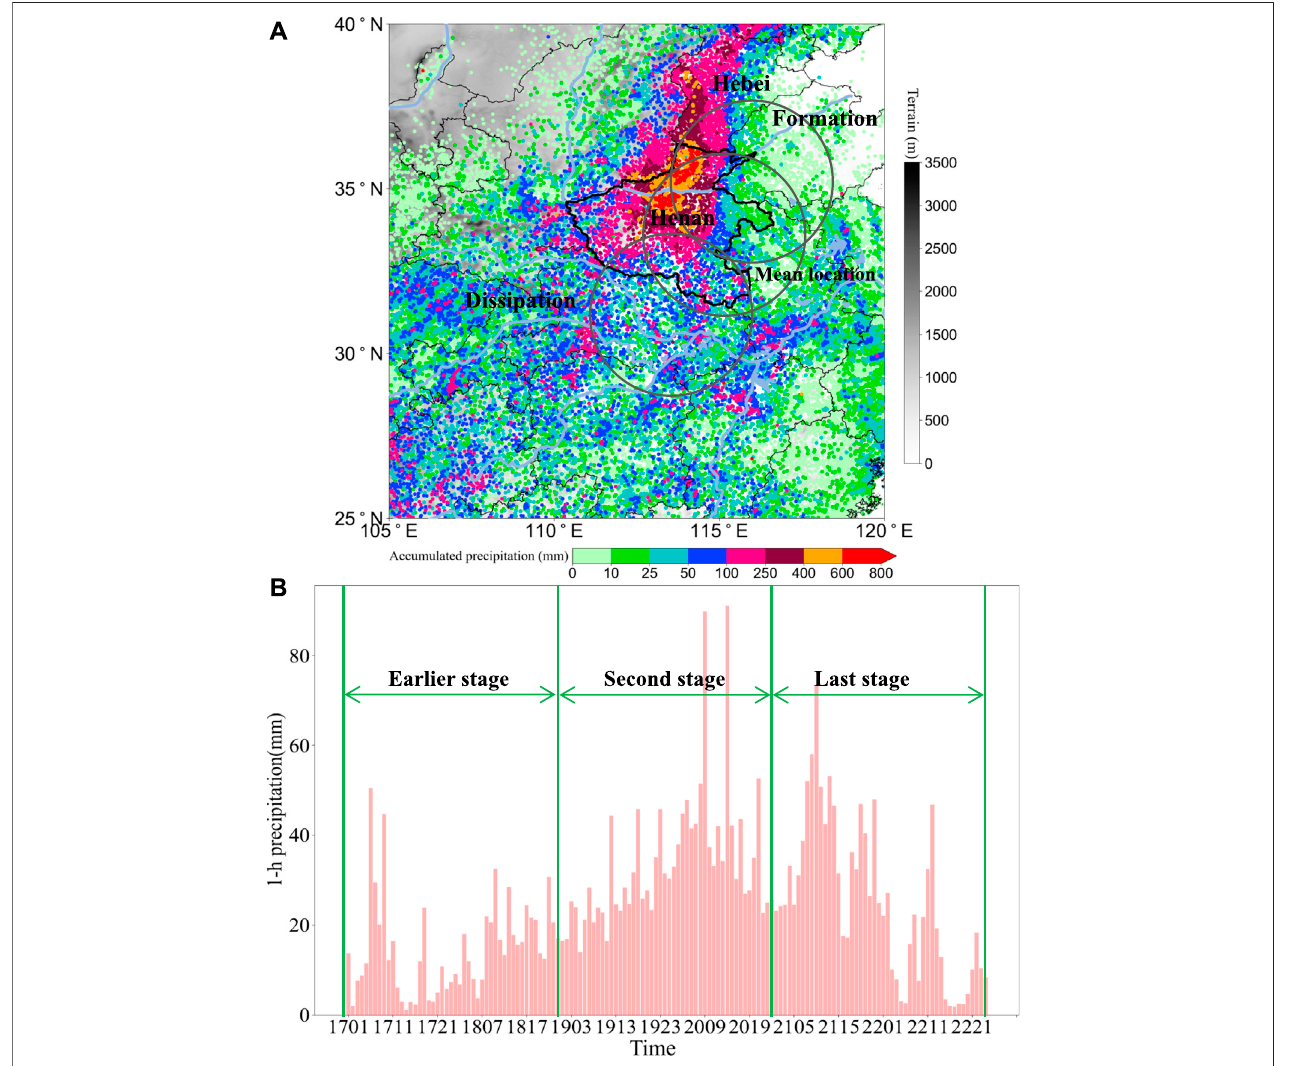
FIGURE 1 | Panel (A) shows the accumulated precipitation (from 1700 UTC to 2300 UTC July 2021) during the “ 21.7 ” Henan heavy rainfall event (shading dots, units: mm),wherethegrayshadingisterrain, andthebiggray circlesoutlinethemainbodyofthevortex atdifferentstages. Panel (B) shows theaveraged(within Henan) hourly precipitation during the “ 21.7 ” Henan heavy rainfall event